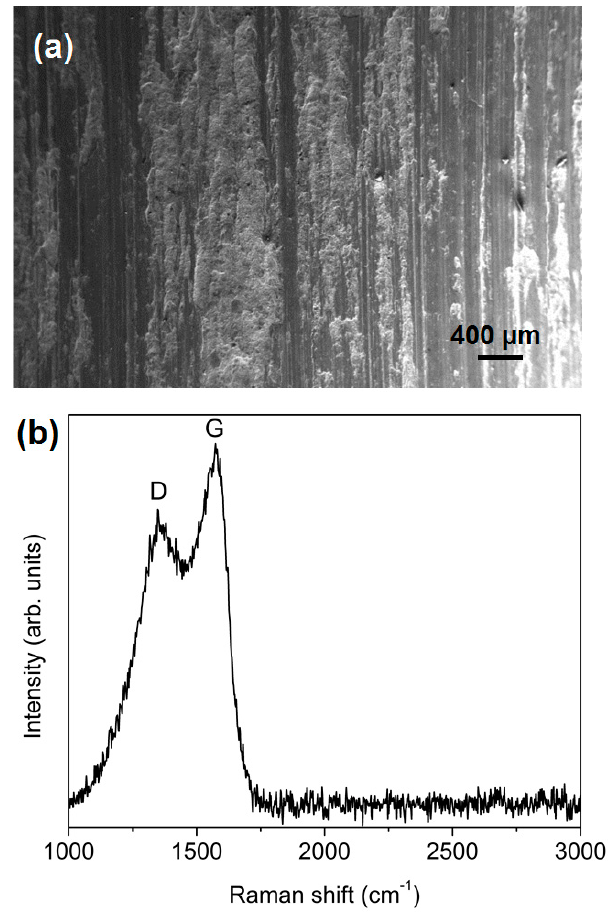
Figure 7. ( a ) SEM image and ( b ) Raman spectrum of the wear surface of the composite GNS/AA1050 obtained via FSP. obtained via